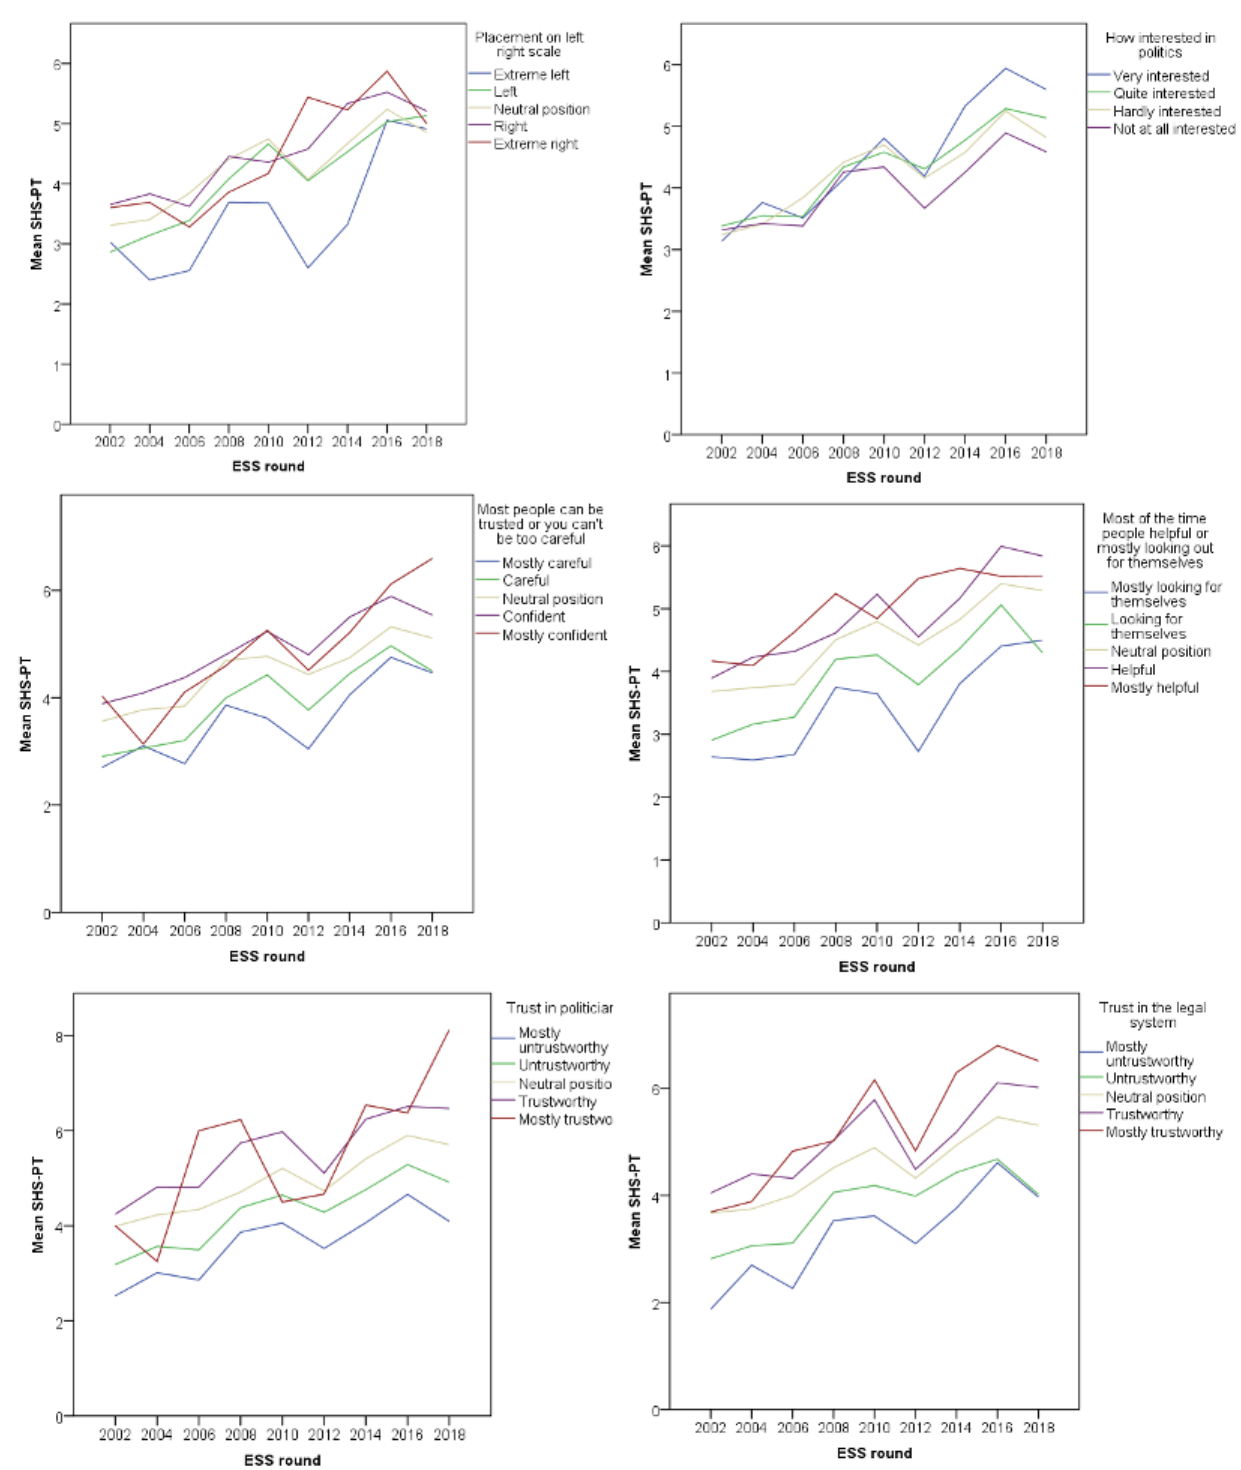
Figure 2. Relationship of Healthcare mean satisfaction levels and support for the role of